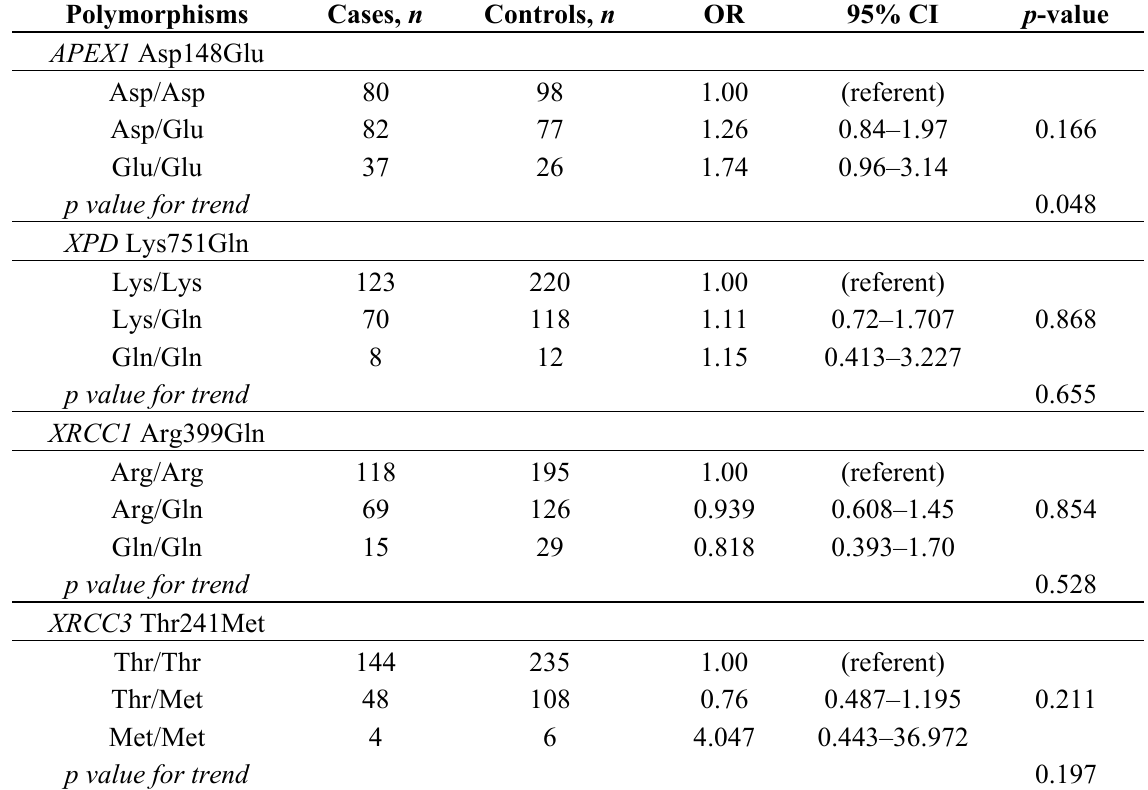
Table 3. Polymorphisms association with